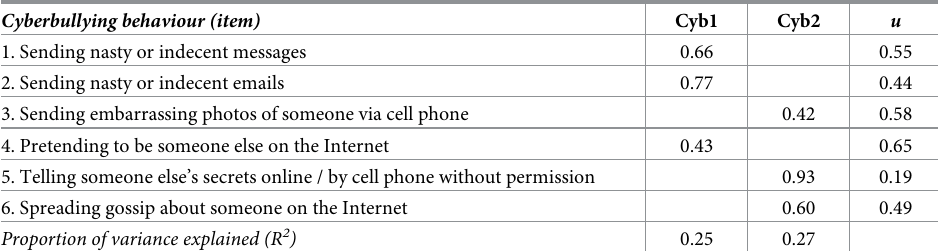
Table 6. Results of the exploratory factor analysis of cyberbullying perpetration. Cyberbullying behaviour (item)